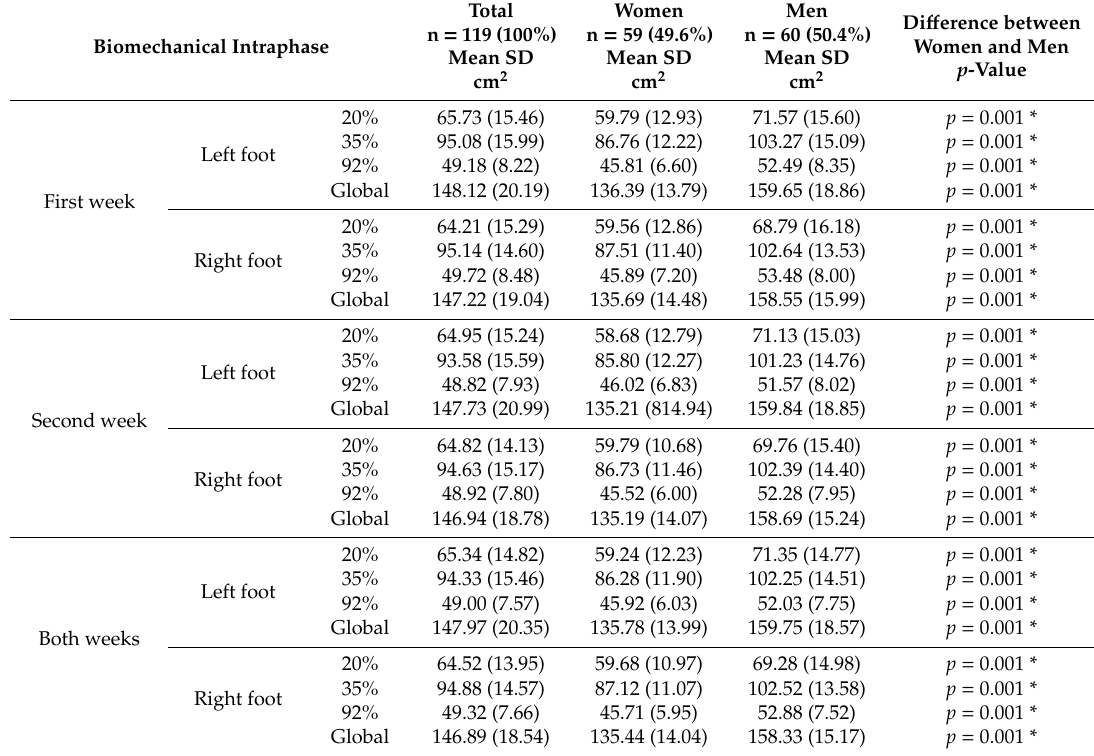
Table 4. Comparison of Women and Men for Contact Surface Areas, First Step.